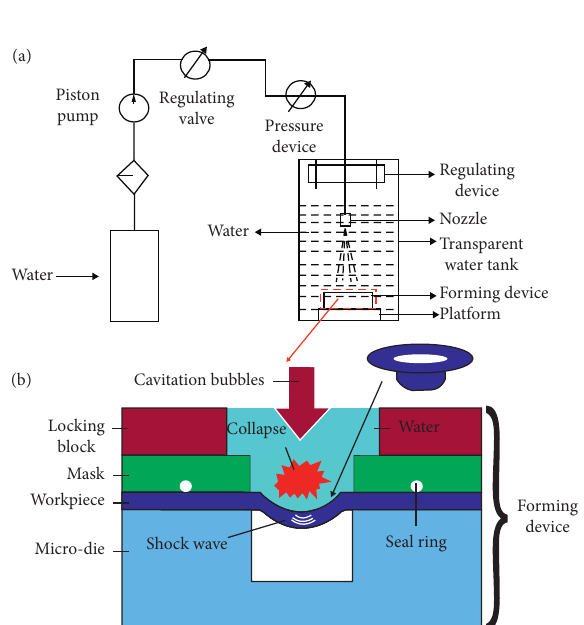
Figure 3: (a) The formation system of water-jet cavitation shock microforming; (b) cross-sectional side